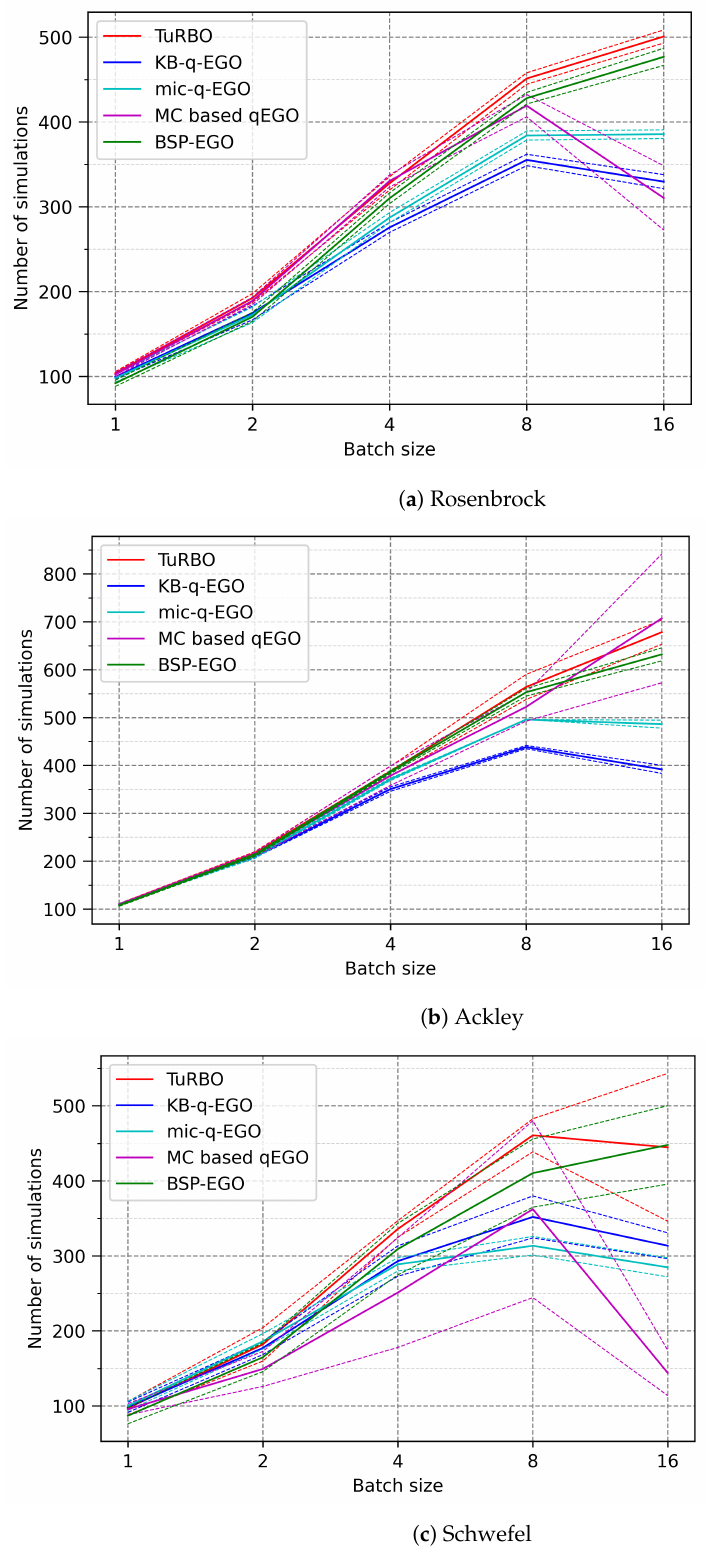
Figure 2. Number of function evaluations as a function of the batch size. Solid lines indicate the average over 10 runs, and dashed lines of same colors indicate the standard